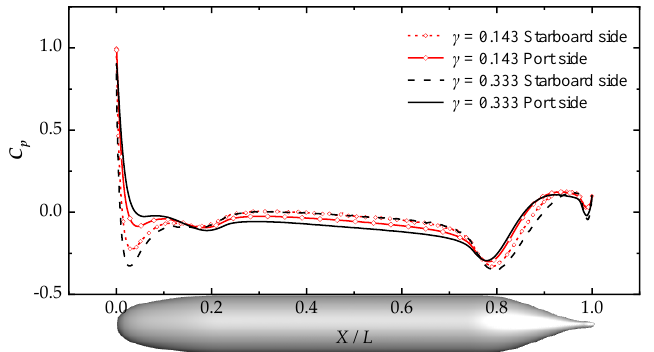
Figure 15. Pressure coefficients along the meridians of the port side and starboard side at different rotation rates.